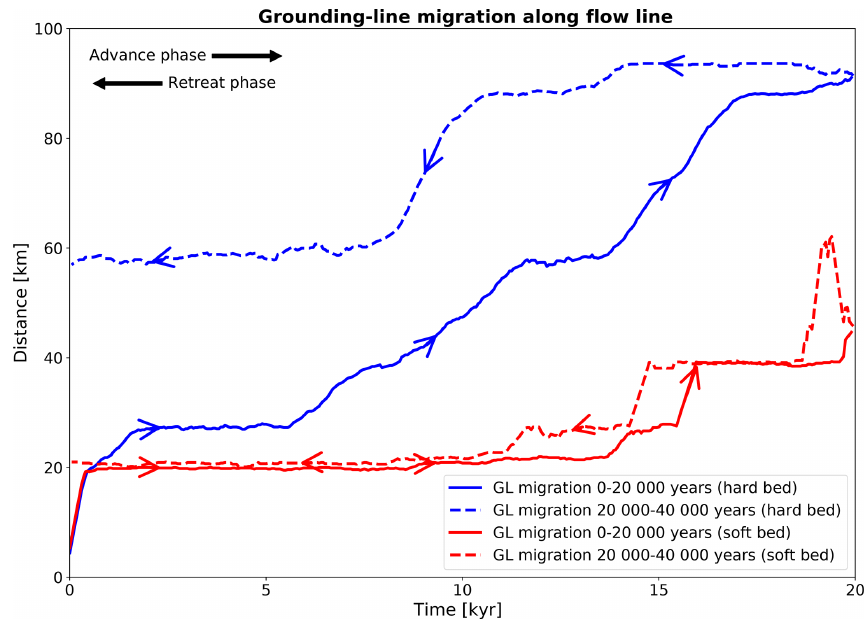
Figure 11. Grounding-line migration along a flow line (A–A (cid:48) in Fig. 1) for the soft- and hard-bed simulations for the advanced (solid lines) and retreat (dashed lines)